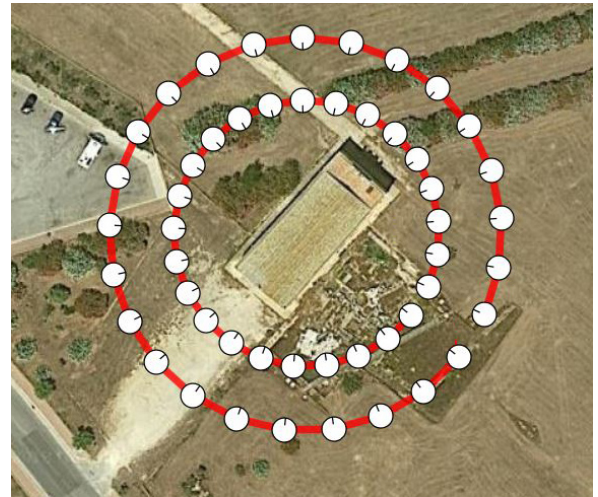
Figure 7. UAV flight plans.